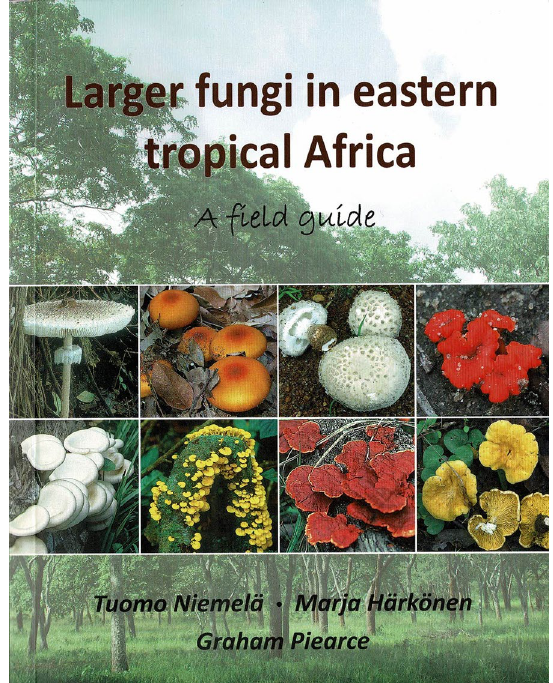
Fig. 23 Larger fungi in Eastern Tropical Africa